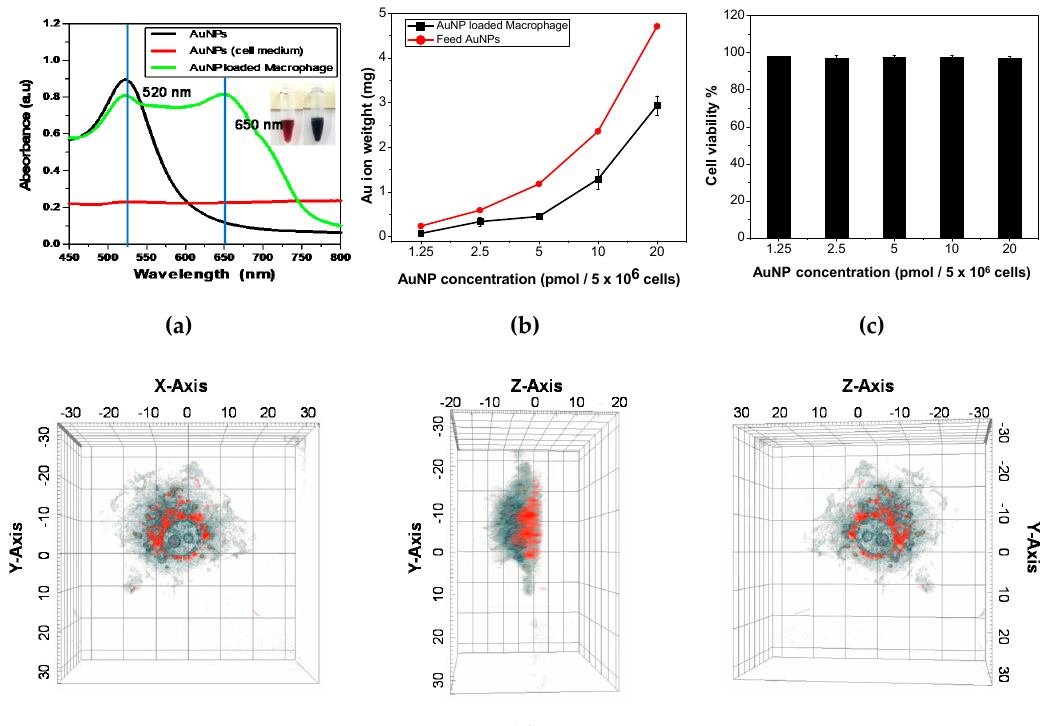
Figure 1. ( a ) Optical image and UV-visible spectrum of AuNPs, AuNPs (cell medium) and AuNP-loaded macrophages (RAW 264.7 cell line). The blue line represents the highest absorbance peak in the graph. AuNP(cell medium) spectra represented losing the characteristic peak of AuNPs in cell medium conditions (without cells). ( b ) Amount of AuNPs uptake in 5 × 10 6 macrophage cells determined by ICP-MS. ( c ) In vitro toxicity test of AuNP in the macrophage cell lines (RAW 264.7) for 24 h. (The cell viability test used 5 × 10 6 macrophages.) ( d ) 3D holotomographic image of AuNP-loaded macrophages; red indicates the locations of AuNPs, blue shows the cell membrane. The 3D image indicated cell membrane (blue) covers the AuNP (red) location in a three of direction view, which means that AuNPs (red) loaded well into macrophages. In the center of a cell, cell membrane color becomes dark due to the thickness of the cell membrane. (The grid lines show each plane of the x, y, and z axis and scale unit is um)